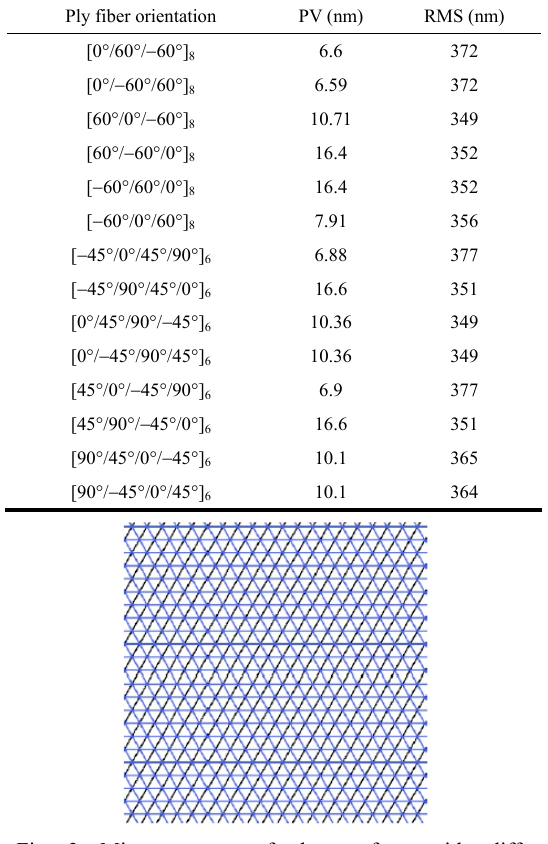
Fig. 3 Microstructure of the surface with different ply-orientations combined.